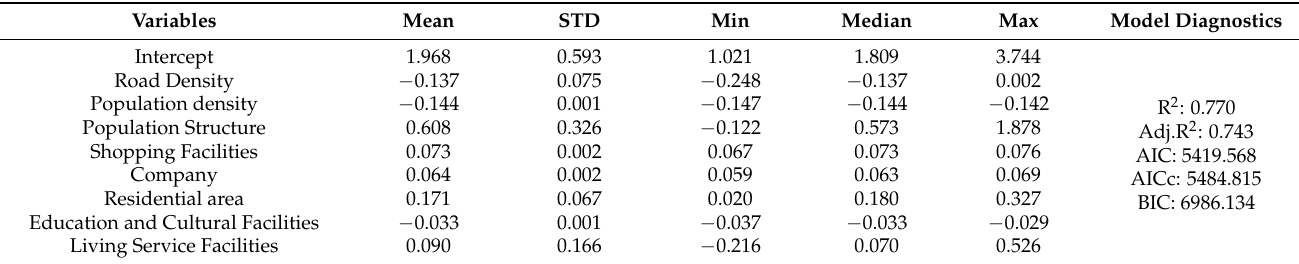
Table 3. MGWR model regression results